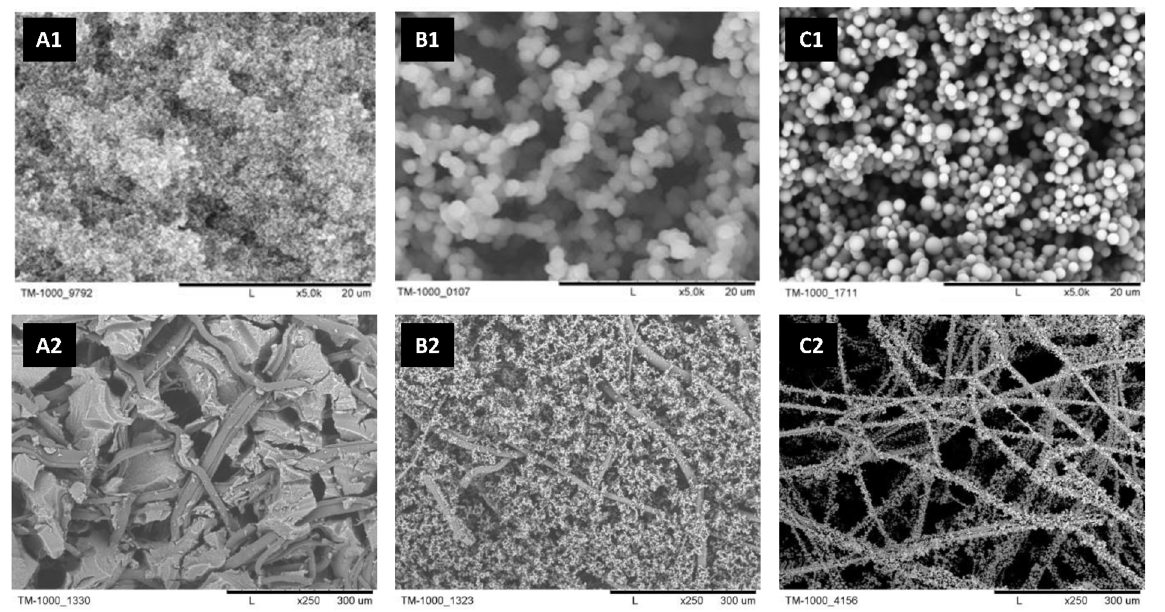
MTMS-based materials: ( A1 – C1 ) gels, ( A2 – C2 ) PP-reinforced MTMS-based constructs.